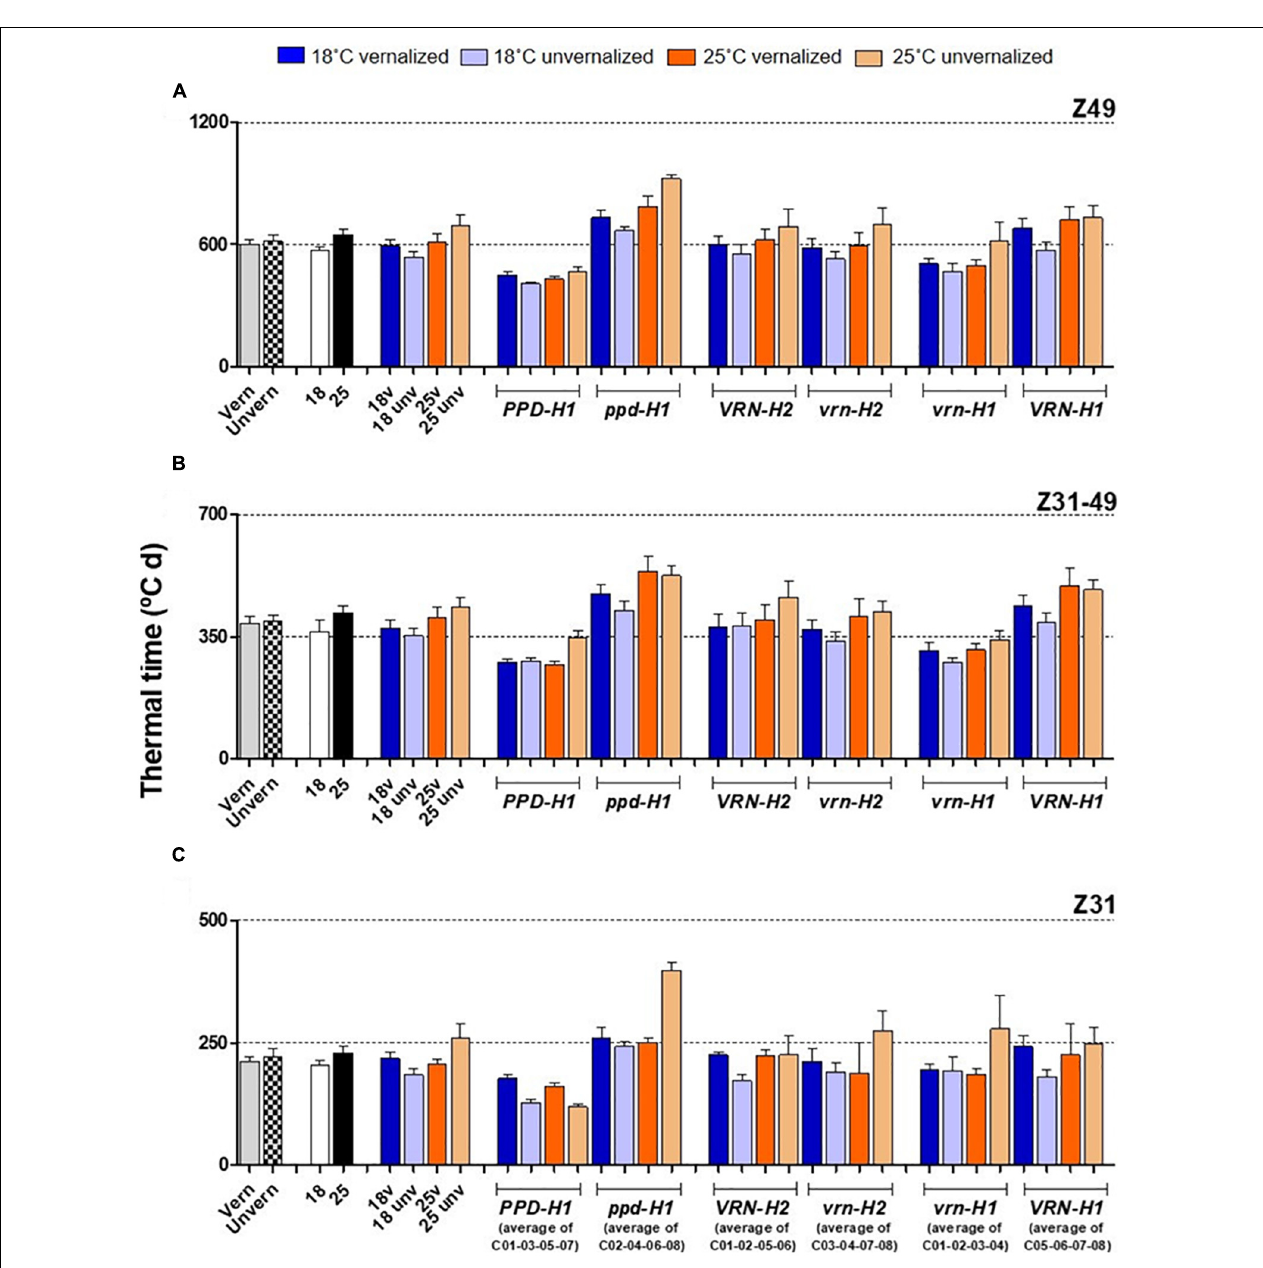
FIGURE 2 | Duration of plant growth phases, with genotypes averaged across classes. The first 8 bars on the left of each panel represent averages of the 8 barley NILs, split by treatments: vernalized and unvernalized, 18 ◦ C and 25 ◦ C, and the four treatments combining vernalization and temperature. The other bars represent averages of the 4 NILs carrying particular alleles at the three genes polymorphic in these NILs, as indicated in the legend of the X-axes: lines classified by PPD-H1 alleles; lines classified by VRN-H2 alleles, and lines classified by VRN-H1 alleles. Duration since the onset of the experiment until flowering (A) from onset of stem elongation until flowering (B) from the onset of the experiment to the appearance of the first node (C) . Bars represent mean ± standard error of the mean (SE). Means were calculated without unvernalized C01 and C02